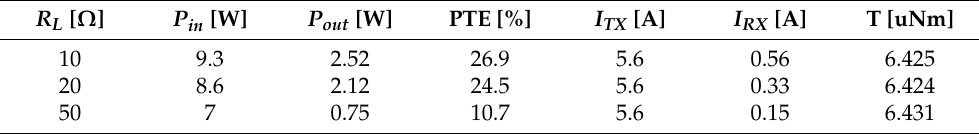
Table 5. Efficiency and torque according to load